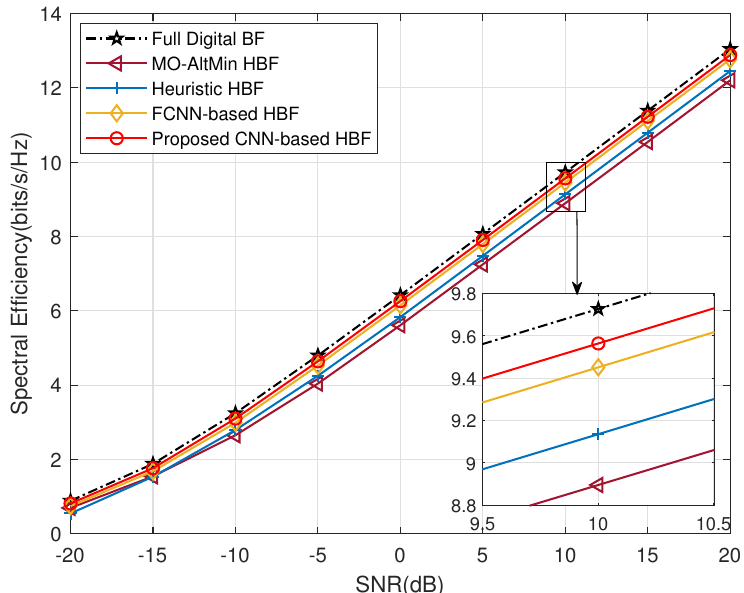
Figure 12. Comparison of spectral efficiency performance of different schemes about specific solution for an individual CSI in geometric mmWave channel with N t =